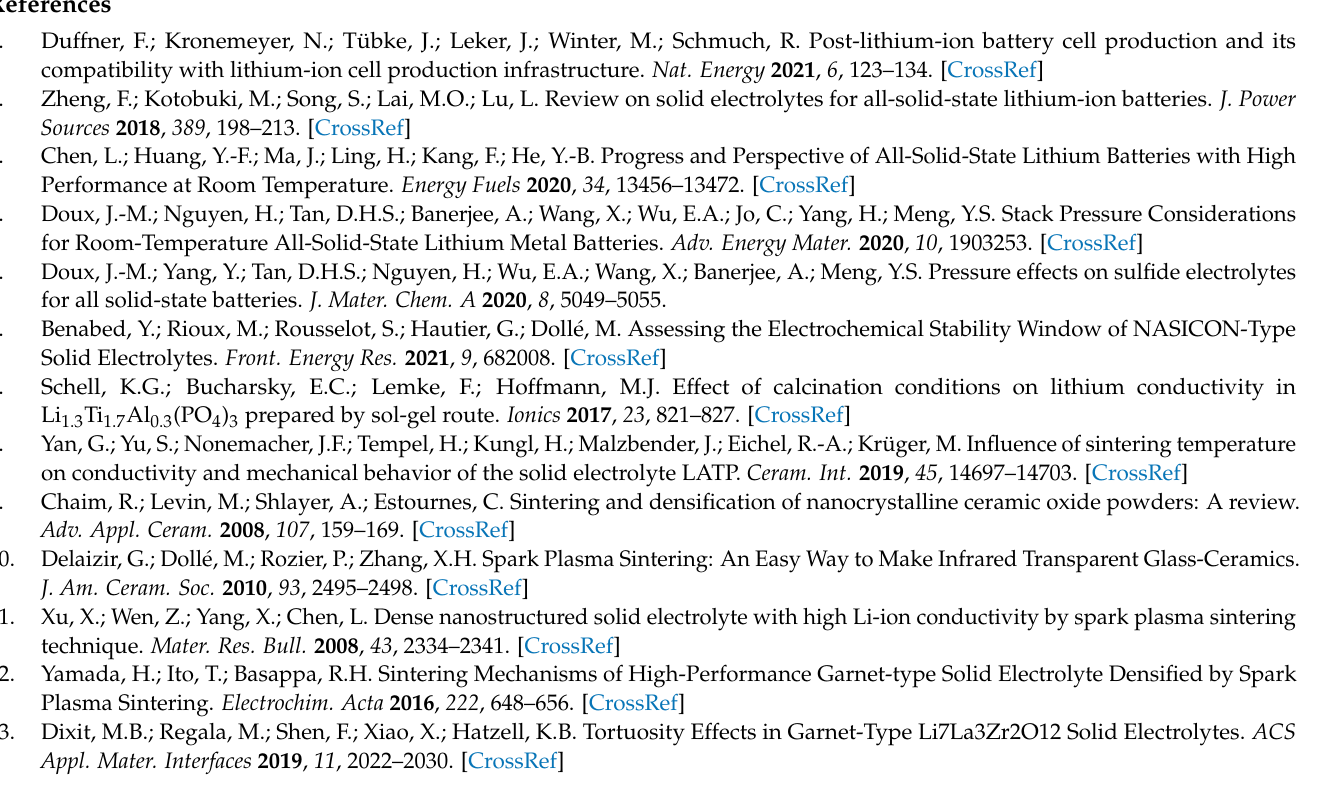
Figure S3: SEM picture of the cross section of the LATP SPS pellet sintered at 850 ◦ C; Figure S4: EIS Diagram at room temperature of the LATP pellet produced by SPS at 850 ◦ C; Figure S5: EIS Diagram of LATP pellets produced by SPS and NS at 850 ◦ C and 500 ◦ C; Figure S6: SEM picture of the cross section of the LATP NS pellet prepared at 500 ◦ C; Figure S7: EIS diagrams at 20 MPa upon decrease of applied pressure for LATP at 70 ◦ C for compact powder (a) and pellet produced by SPS at 850 ◦ C (b); Figure S8: EIS diagrams at RT at 20 MPa upon decrease of applied pressure for PEO-LATP75 without LITFSI